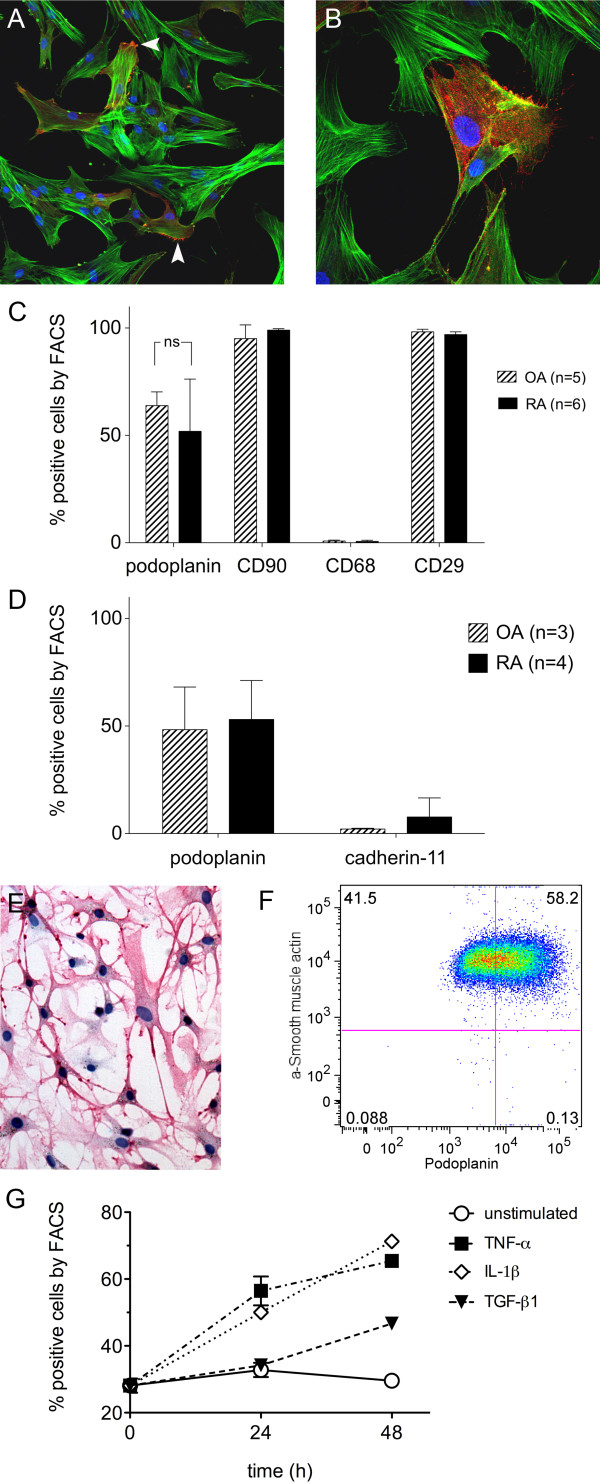
Podoplanin is expressed in cultured primary FLS and the expression is increased by pro-inflammatory cytokines. (A) Immunofluorescence staining of primary rheumatoid arthritis fibroblast-like synoviocytes (RA-FLS) showing podoplanin (red) and actin stress fibres (green). Note accumulated podoplanin staining in membrane protrusions (arrowheads). (B) Magnification of podoplanin-positive RA-FLS. (C and D) Flow cytometry (FACS) of primary FLS cultures from patients with RA (filled bars) and patients with osteoarthritis (OA) (striped bars) showing the percentage of positive cells of viable cell populations using (C) antipodoplanin and phenotype markers (CD90, CD68 and CD29) and (D) cadherin-11 antibodies. (E) Immunocytochemistry of an aggressively growing RA-FLS culture using antipodoplanin antibody. Note the dendritic phenotype with long cytoplasmatic protrusions. (F) Representative flow cytometry plot of primary RA-FLS stained for podoplanin and α-smooth muscle actin (α-sma) showing the double-positive population (podoplanin+ and α-sma+) of 58.2% in the upper right quadrant. (G) Graph showing the percentage of podoplanin-positive primary FLS by flow cytometry at baseline, 24 and 48 hours of stimulation with control (complete medium) (open circles), 10 ng/ml tumour necrosis factor (TNF)-α (filled squares), 1 ng/ml interleukin (IL)-1β (open diamond) and 1 ng/ml transforming growth factor β receptor 1 (TGF-β1) (filled triangles), respectively, of a representative culture. The experiment was run in triplicate and repeated four times using different OA-FLS and RA-FLS cultures, which showed similar results but starting at different baseline levels of podoplanin expression.